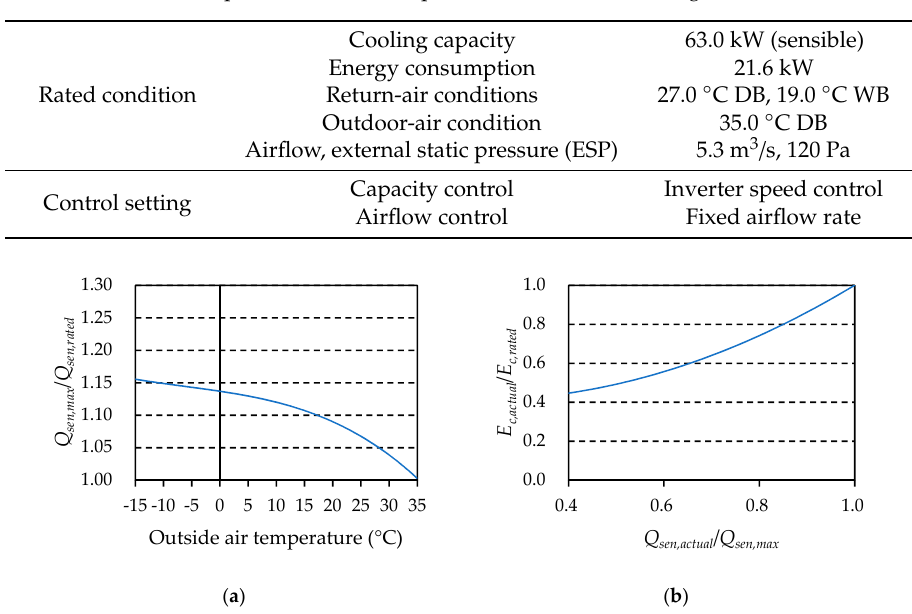
Figure 15. Examples of characteristics of CRAC: ( a ) Change in maximum sensible cooling capacity with respect to outside-air temperature (return-air conditions, airflow, and external static pressure (ESP) are as listed in Table 9) and ( b ) change in power consumption with respect to partial load (return-air conditions and outdoor-air condition, airflow, and ESP are as listed in Table 9), where E c,actual is actual power consumption of the CRAC, E c,rated is rated power consumption of the CRAC, Q sen,actual is actual sensible cooling capacity, Q sen,max is maximum sensible cooling capacity, and Q sen,rated is rated sensible cooling